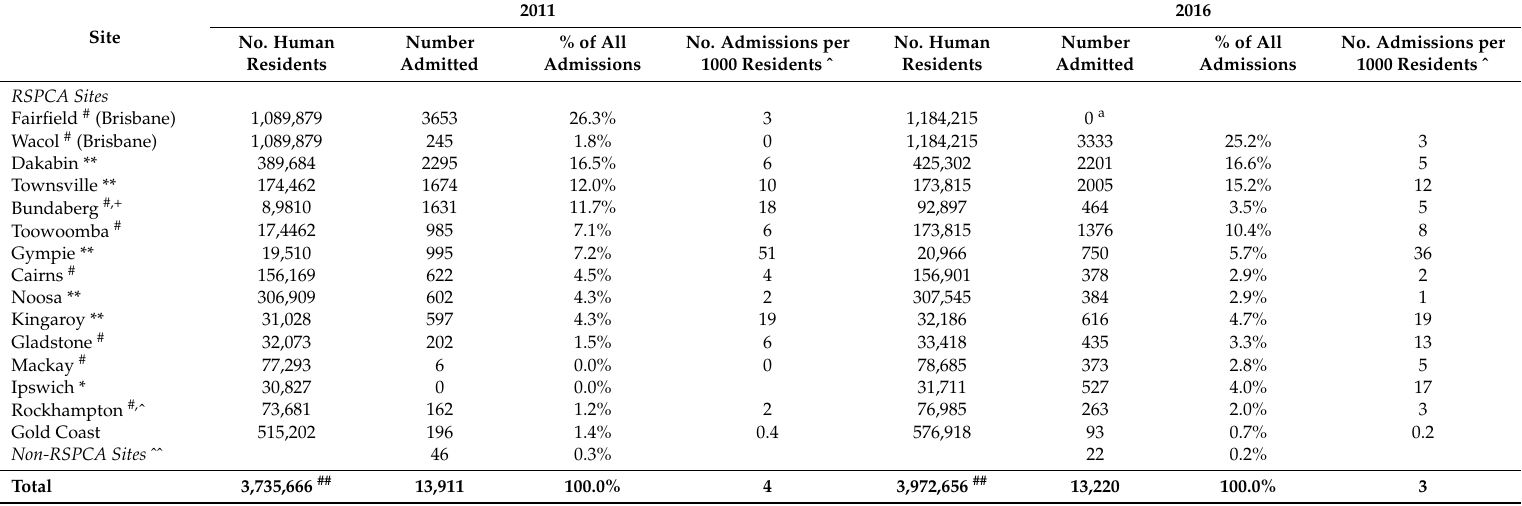
Table A1. Summary of all cat admissions into RSPCA Queensland by site for 2011 and 2016, and associated numbers of human residents and numbers of admissions per 1000